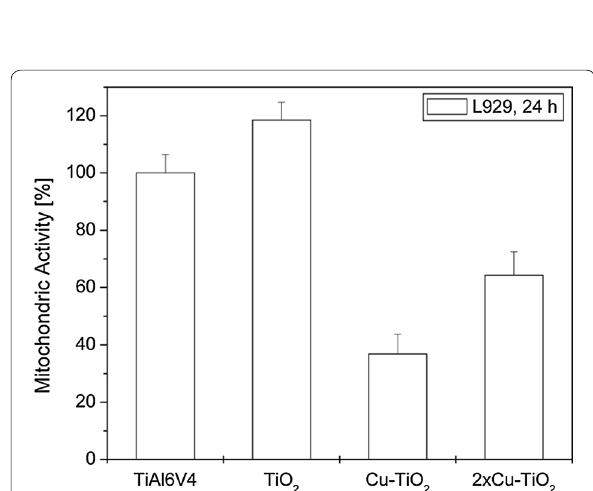
Fig. 5 Cell vitality of fibroblasts L929 on uncoated and the different TiO 2 -coated Ti6Al4V